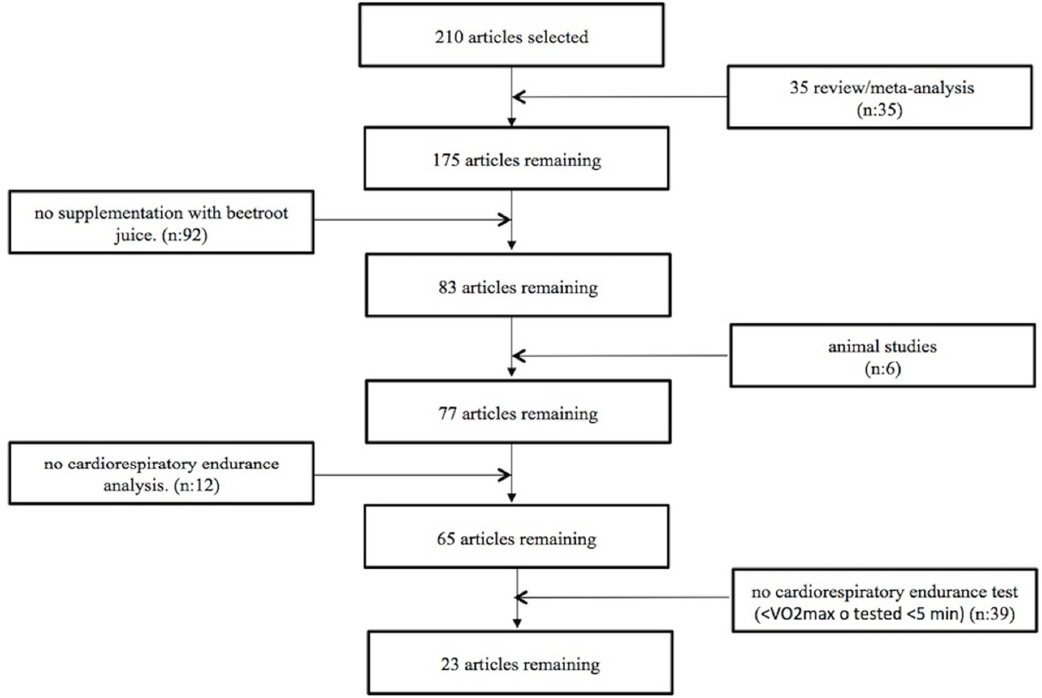
Figure 2. Flowchart of article selection.